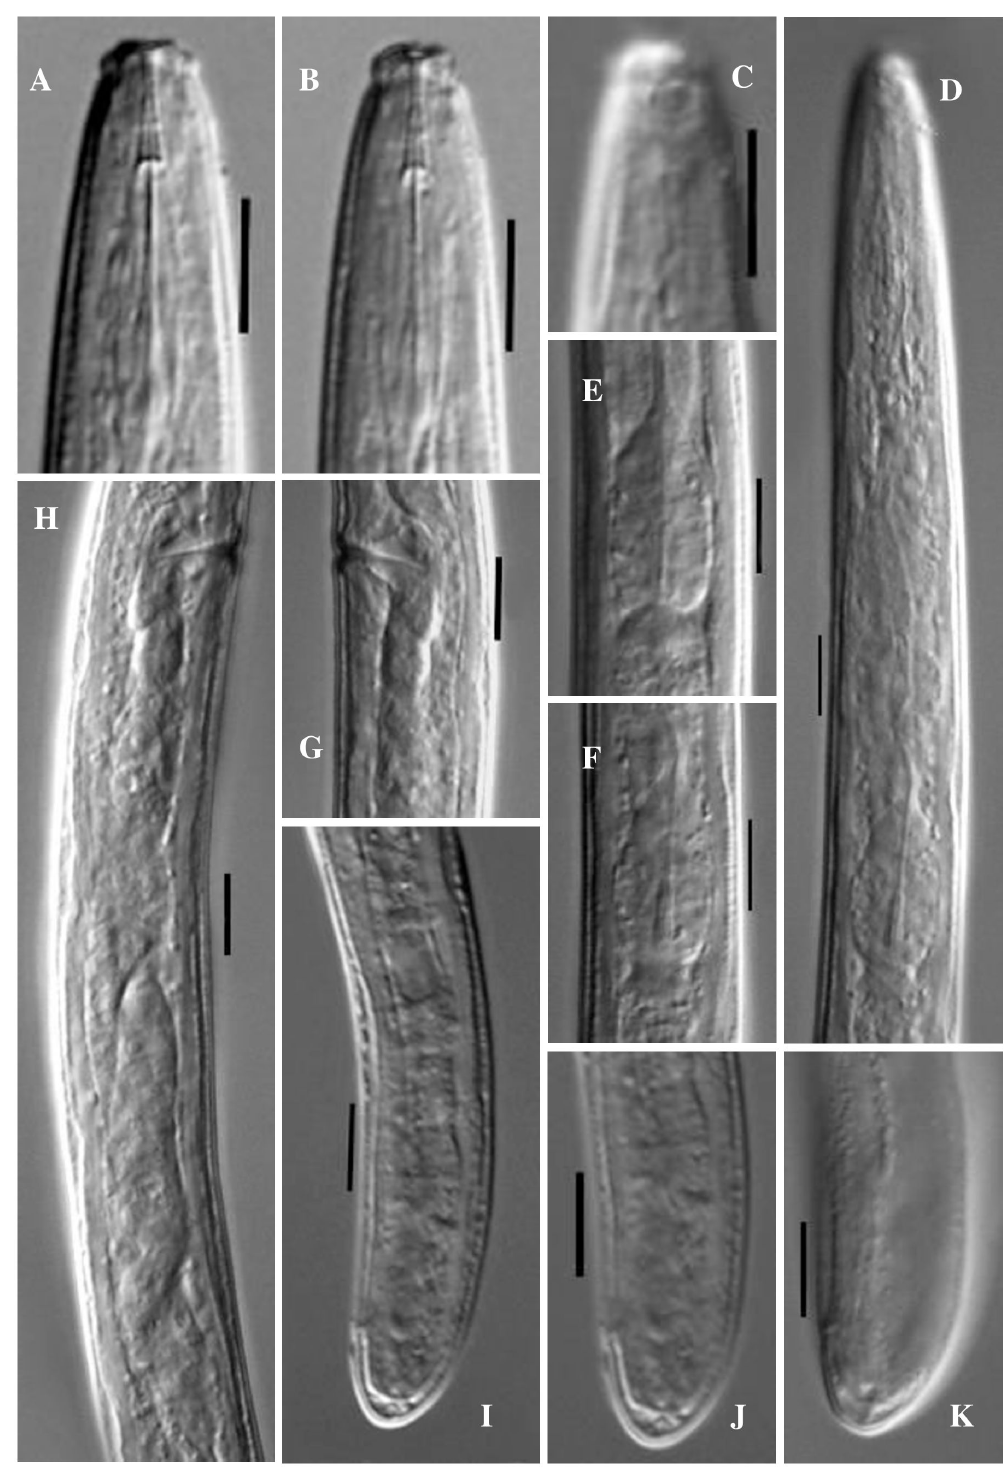
Fig. 7. Basirotyleptus minutus Khan, 1987, ♀ (AMU/ZD/NC/ Basirotyleptus minutus /1) (LM photographs). A–B . Anterior region. C . Anterior region showing amphid. D . Pharyngeal region. E–F . Pharyngeal bulb. G . Vulval region. H . Genital system. I . Posterior region. J–K . Posterior end. Scale bars = 10